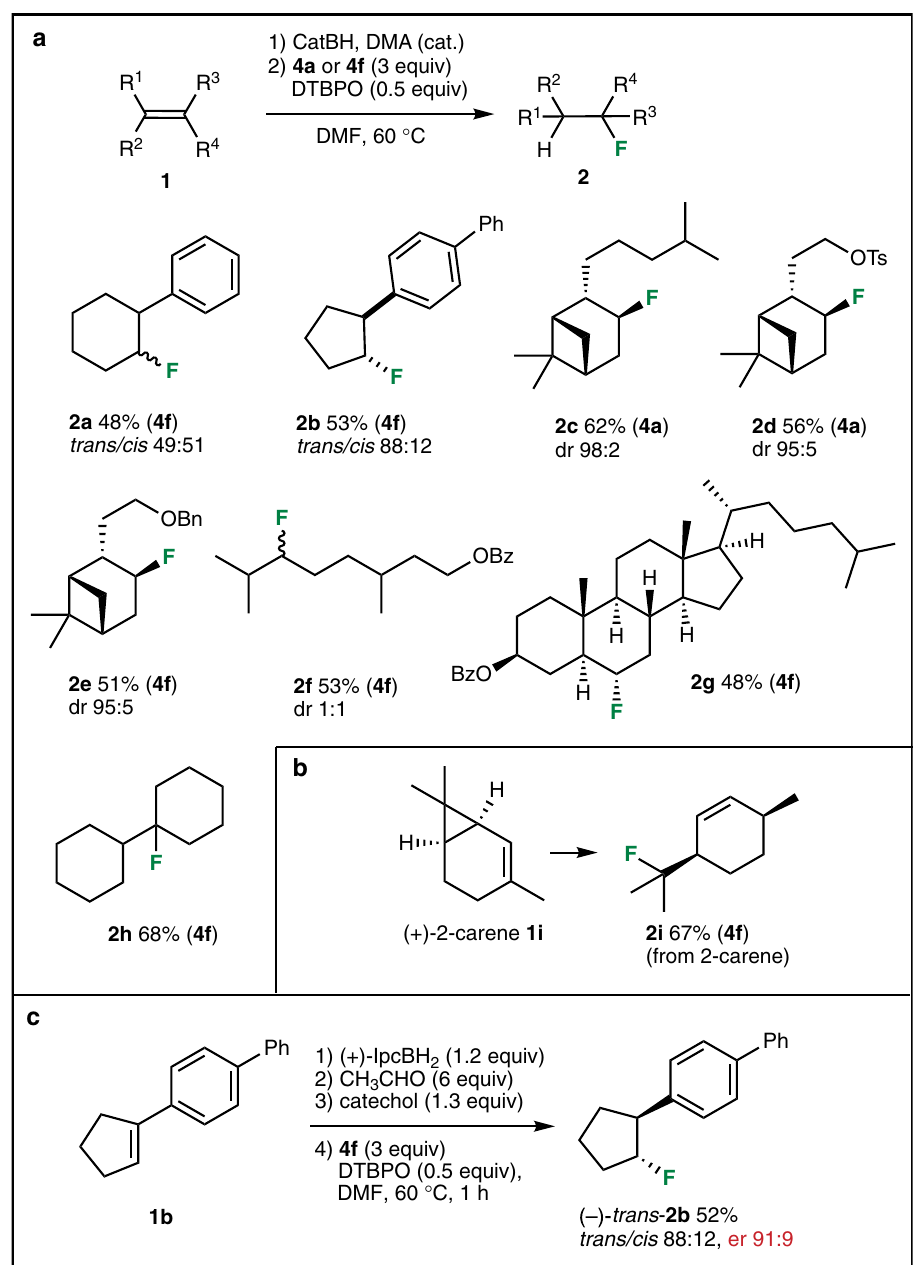
Fig. 4 Hydro fl uorination of non-terminal alkenes. a The reaction works ef fi ciently with secondary and tertiary radicals derived from di- and trisubstituted alkenes, respectively. b The radical nature of the process is demonstrated by the ring-opening process observed with ( + )-2-carene 1i . c Preparation of the enantioenriched fl uoride ( – )- trans - 2b from alkene 1b is possible using ( + )-isopinocampheylborane in the hydroboration step. Isolated yields are